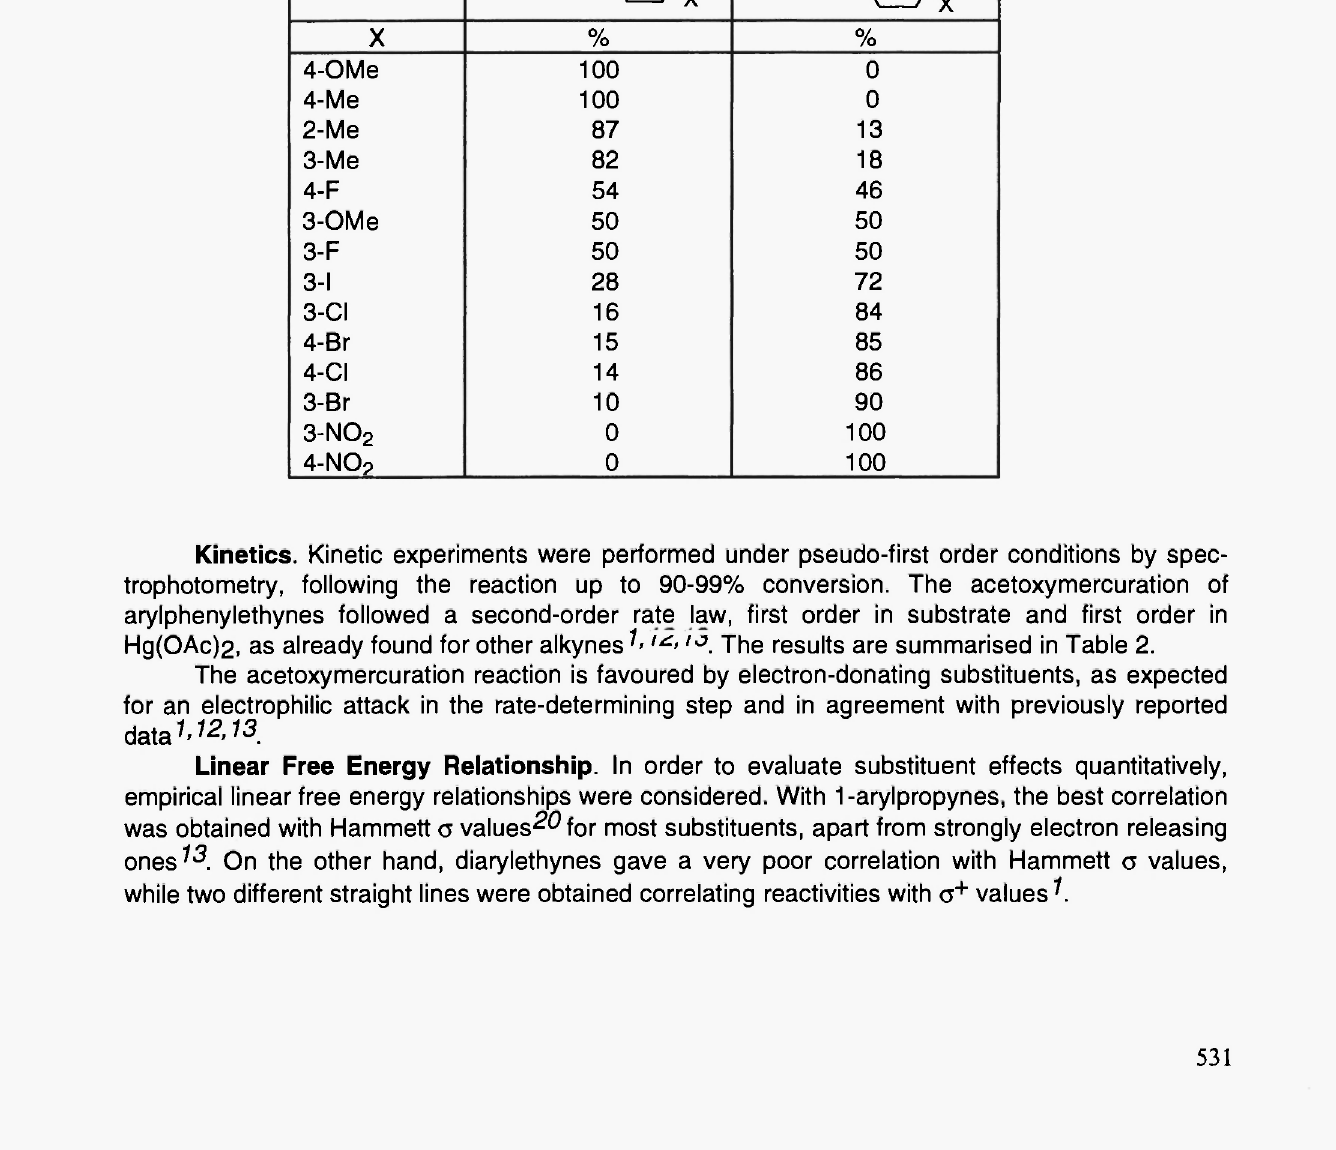
Table 1. Relative percentages of addition products from acetoxymercuration of arylphenylethynes.